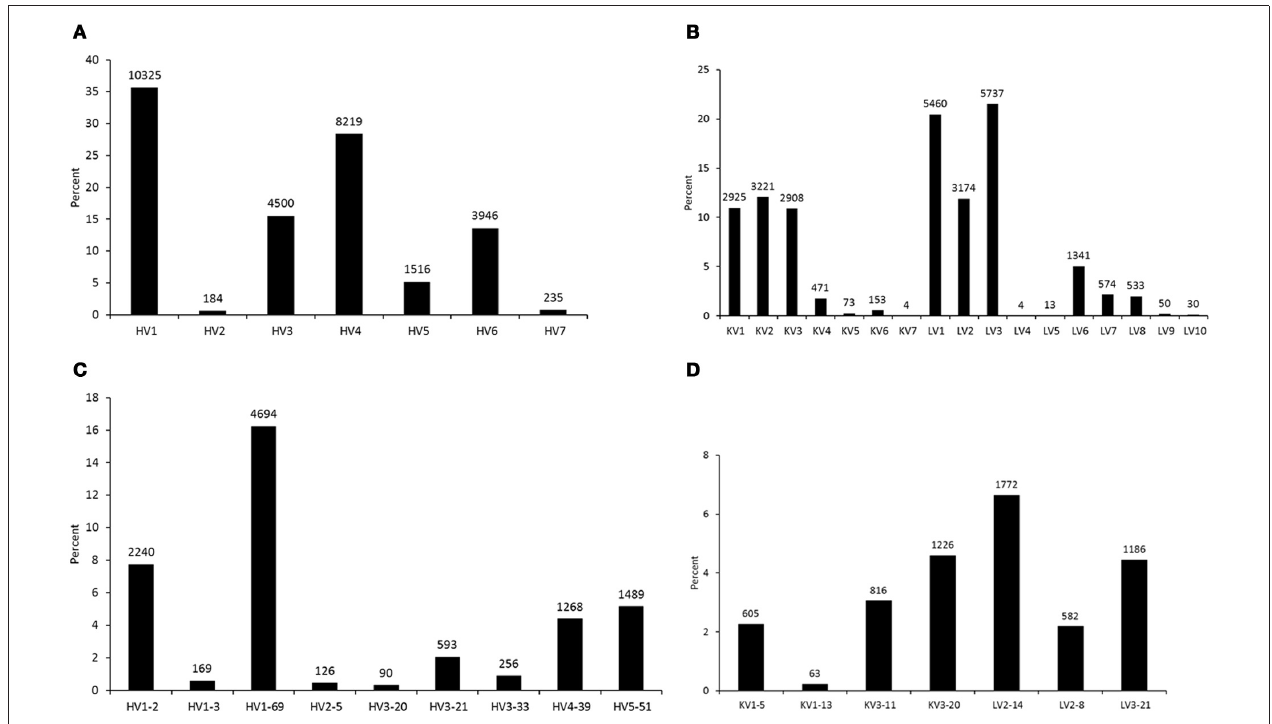
FIGURE 1 | Germline usage frequencies. The heavy (HV) and light (KV for κ and LV for λ ) chains as observed in the 454 sequencing of a human naïve IgM library are shown in (A) and (B) , respectively. The frequencies of V-genes